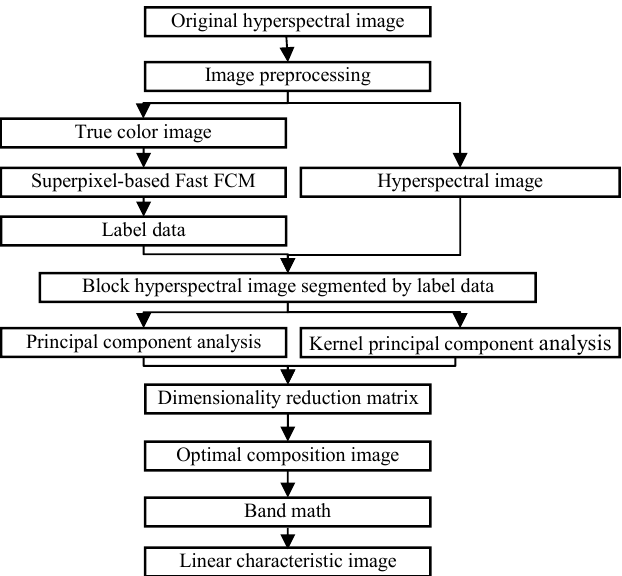
Figure 2 . Linear feature enhancement